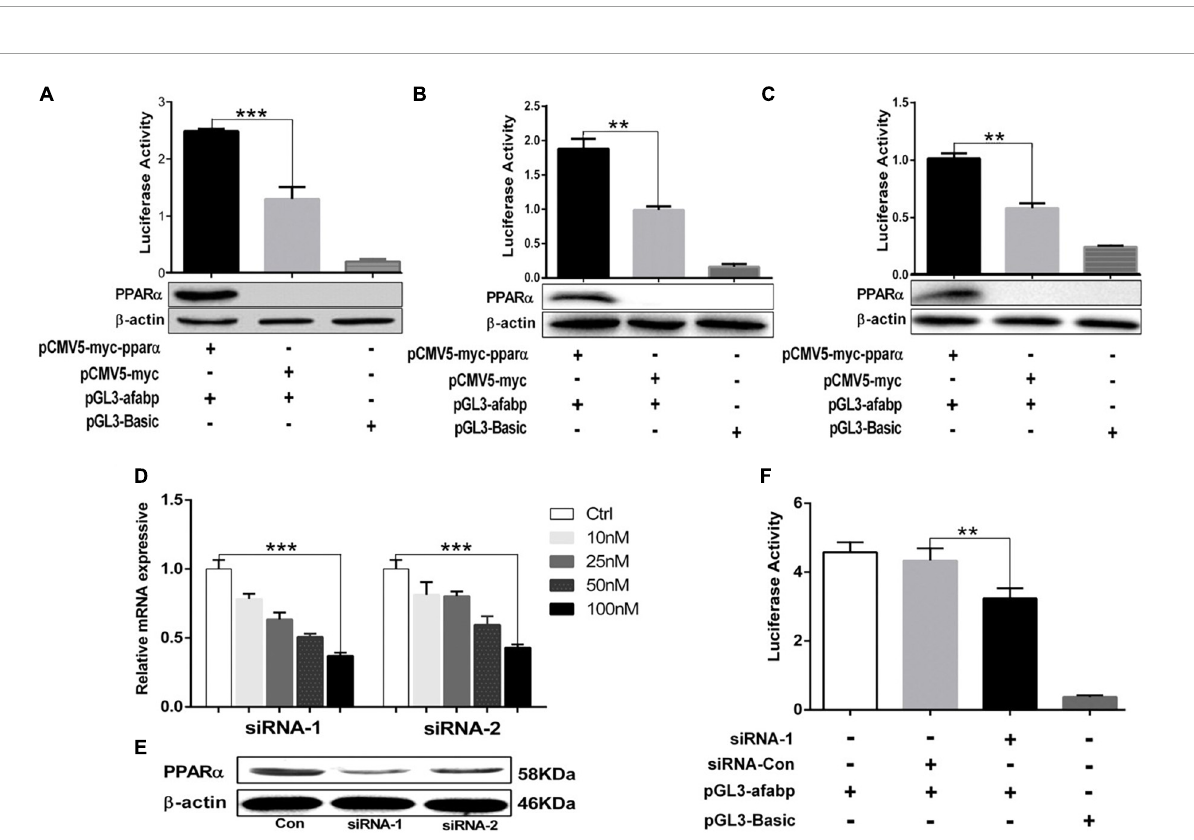
FIGURE2 PPAR α increased the activity of A-FABP promoter. (A–C) The 293T (A) , C2C12 (B) and 3T3-L1 (C) cell were co-transfected with pGL3-afabp, pCMV5-myc-ppar α , pGL3-Basic, pRL-TK or pCMV5-myc for 48 h. Dual luciferase reporter gene system was used to detect the activity of A-FABP promoter (upper panel), and western blotting was performed to detect PPAR α expression (lower panel). PK15 cells were transfected with the indicated siRNAs targeting porcine PPAR α at different concentrations (10, 25, 50, and 100 µ M). RT-qPCR (D) and western blotting (E) were performed to detect the expression level of PPAR α , and GAPDH was used as an internal reference gene. (F) PK15 cells were transfected with pGL3-afabp or pGL3-Basic for 24 h and then treated with siRNA-1 or siRNA-Con as indicated. Dual luciferase reporter gene system was used to analysis the activity of the A-FABP promoter. Data were analyzed by t -test. ** P < 0.01, *** P < 0.001.